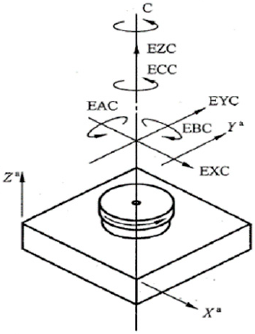
Figure 1. Error motion of rotary axis.